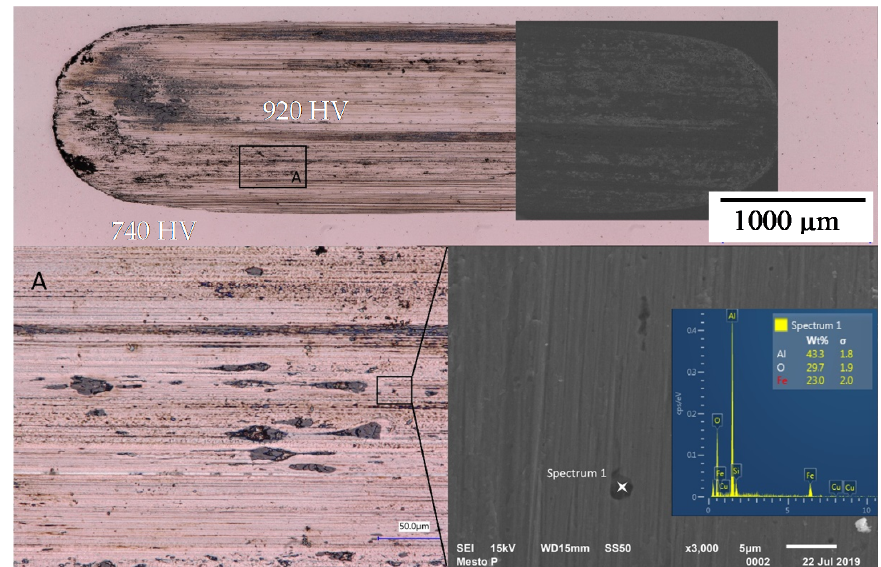
Figure 4. Abrasive wear test scar of SIHARD S250 steel with the corresponding SEM images and EDS spectra.